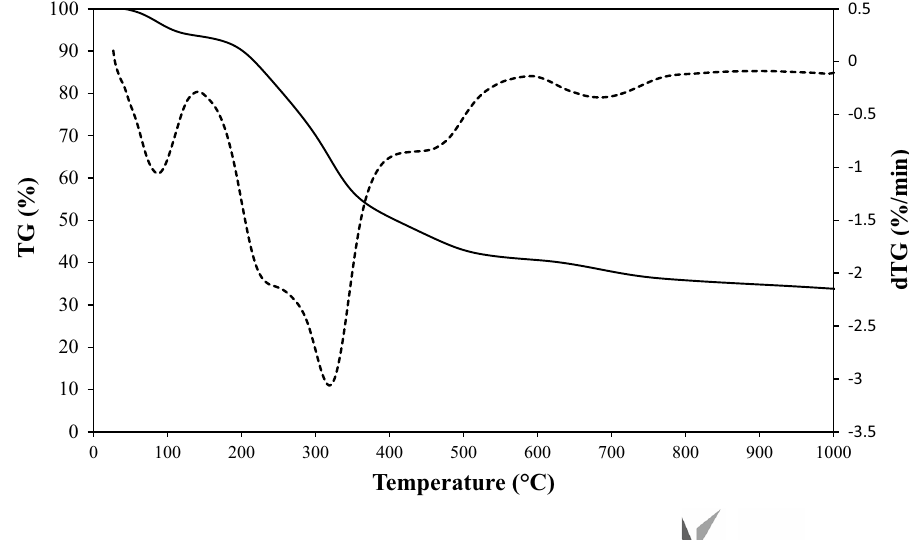
Fig. 1 TG and dTG curves of raw chickpea